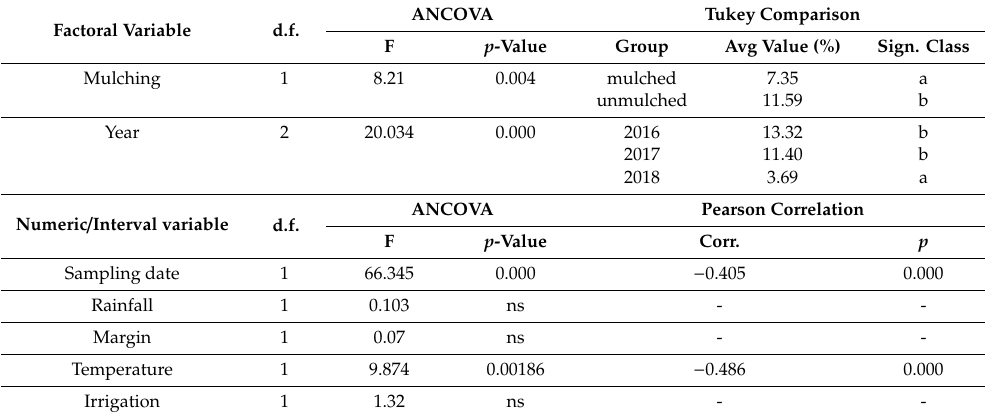
Table 4. E ff ect of explanatory variables on total weed coverage (%) in an open-field tomato experiment (Gödöll˝o, Hungary, 2016–2018). Factoral Variable